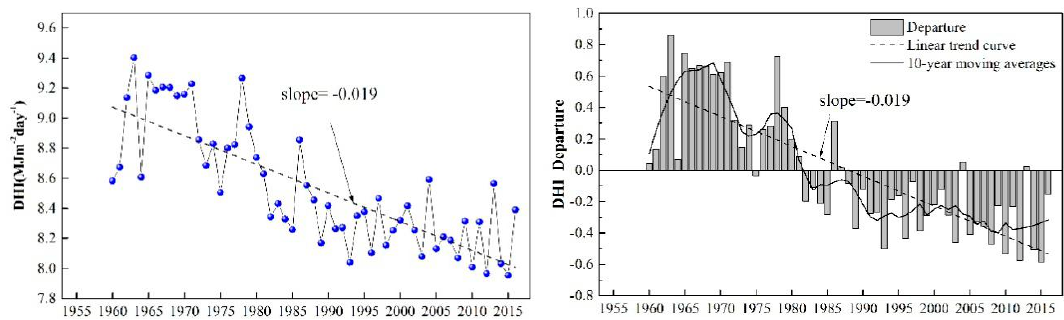
Figure 8. Time series of annual mean DHI (MJ m − 2 day − 1 ) for China during 1960–2016. Figure 9 indicates the spatial pattern of the annual average DHI values over mainland China.